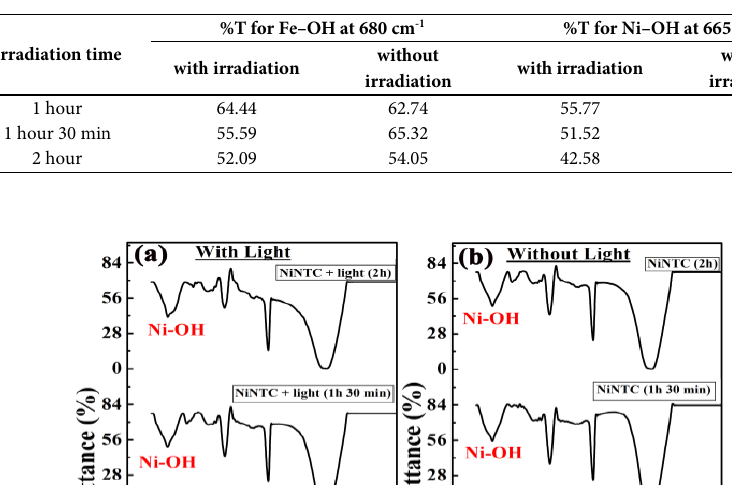
Fig. 4. FTIR spectra of nickel nitrate treated with TiO